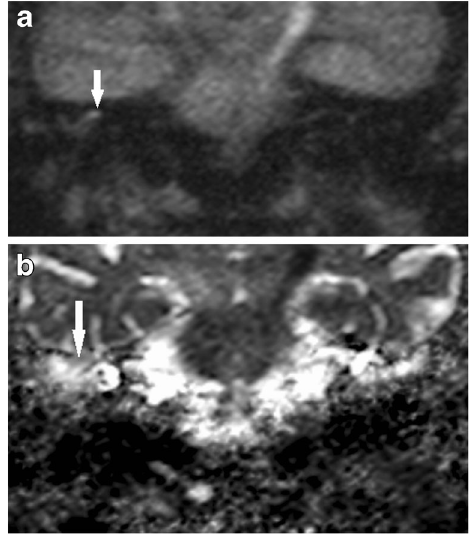
Fig. 9 False positive high DWI signal for cholesteatoma. Non- cholesteatomatous tissue (surgically confirmed non-specific inflammation) at the post-operative mastoid remnant, which demonstrated a high signal ( white arrow ) on the b1000 image suggestive of residual cholesteatoma. However, b the corresponding ADC map demonstrated borderline high ADC signal ( white arrow ) and value not supporting the diagnosis of residual cholesteatoma. This case could also have been resolved with a follow-up DWI scan